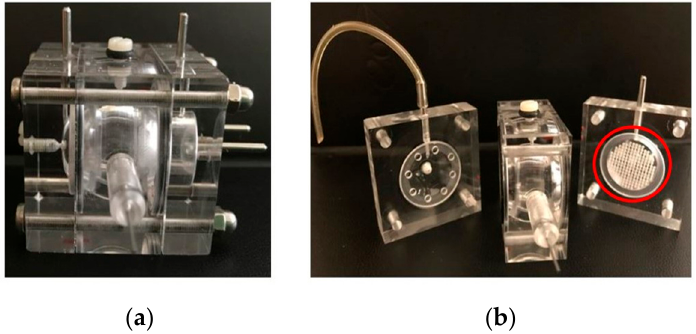
Figure 23. Ocular flow cell: ( a ) the three-compartments unit secured with four screws; ( b ) the red-circled semipermeable disk, possible support for retinal cells.